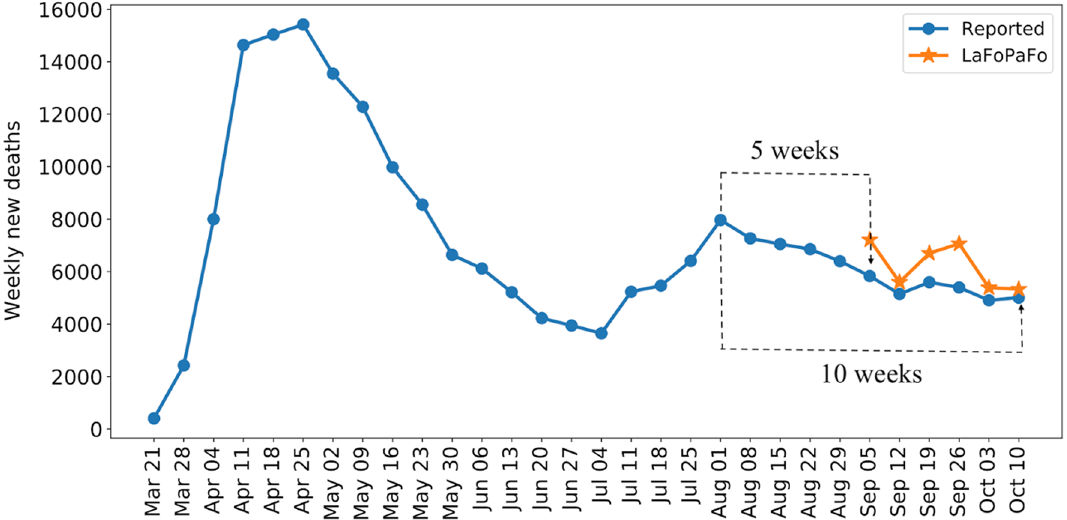
Figure 3. LaFoPaFo’s projected number of deaths from 5 to 10 weeks in the future. The forecasts are made based on data accumulated to the week of August 1, 2020.